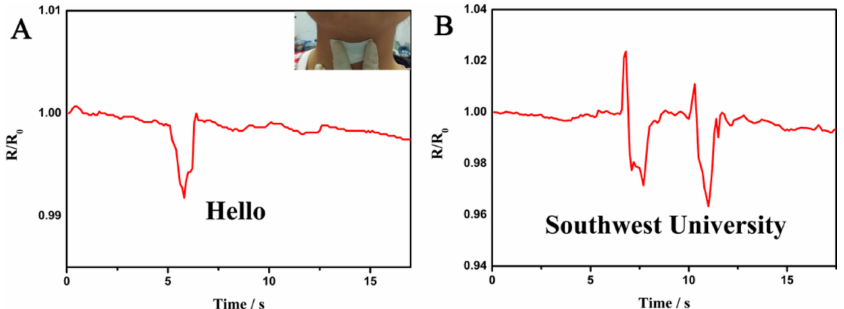
Figure 7. Real-time measurements of vocal-cord vibrations using a throat-attached nanofiber mat-based sensor when the volunteer is speaking “Hello” ( A ) and “Southwest University” ( B ),